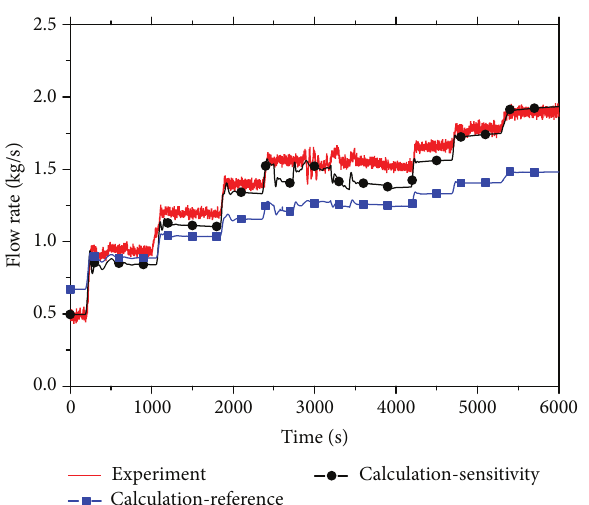
Figure 10: Estimated bypass heat transfer.